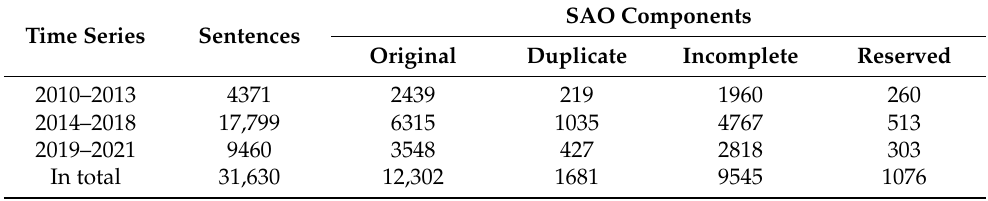
Table 3. Number of SAOs for market